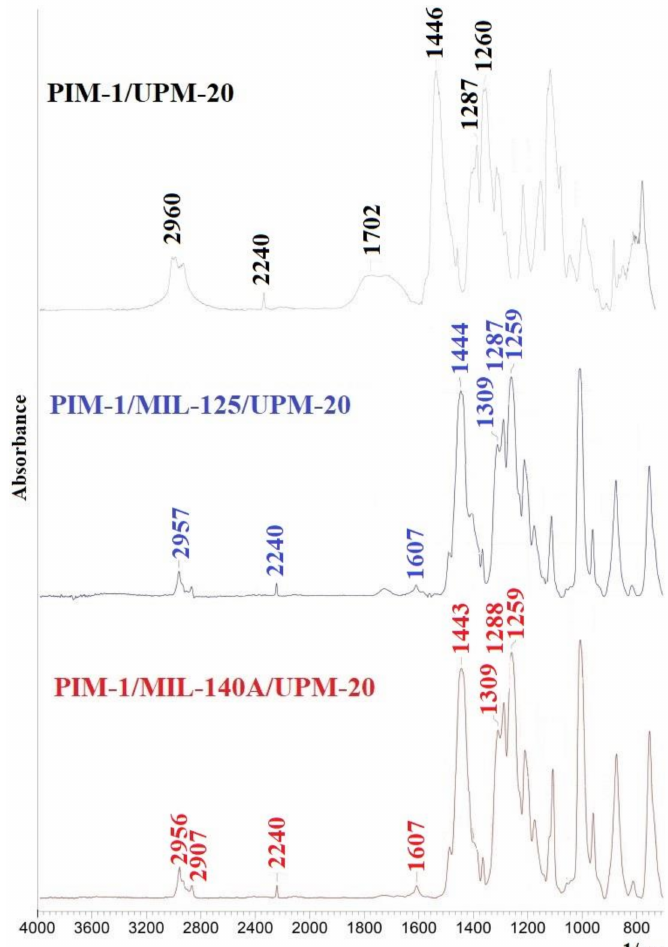
Figure 13. IR spectra of nanofiltration-supported PIM-1 and PIM-1/MOFs